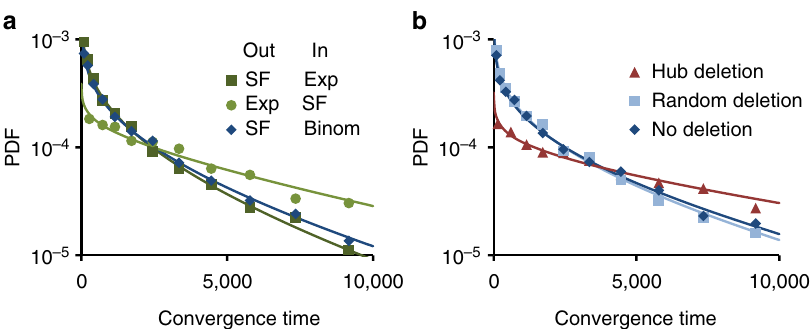
Figure 6 | Distribution of convergence times for networks which converged in less than 10 4 timesteps. Solid lines depict stretched exponential fits. ( a ) Probability density distribution (PDF) of convergence time for three topological ensembles. ( b ) PDFs after deleting the 8 largest hubs (red) or the same number of randomly-chosen nodes (light blue) from the SF-Binom ensemble. All ensembles have N ¼ 1,000, y (cid:5) ¼ 0, g 0 ¼ 10, and D ¼ 10 (cid:2) 3 . Degree distribution parameters: SF, ( a ¼ 1, g ¼ 2.4); Binom, p ’ 3 : 5 ; N (cid:2) (cid:3) ; Exp, ( b ¼ 3 : N